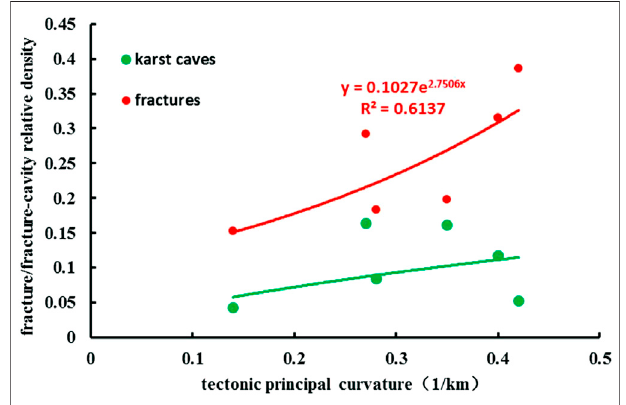
FIGURE 11 | Relationship between the tectonic principal curvature and relative density of fractures or karst